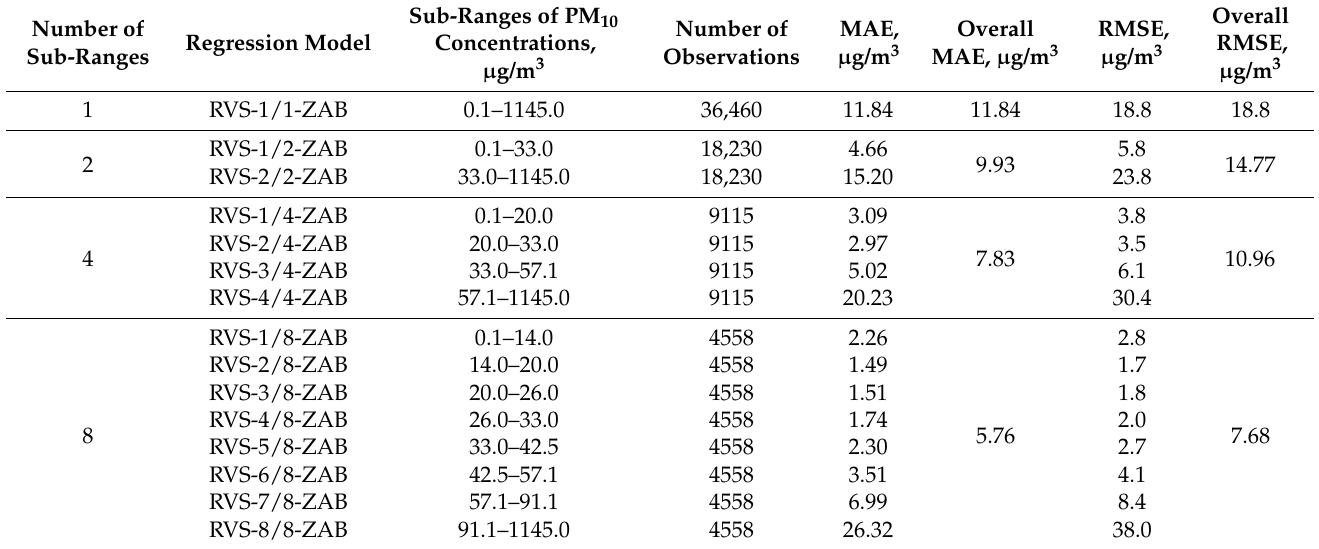
Table 21. Values of approximation errors of PM 10 concentrations in RVS models, Zabrze 2011–2016.